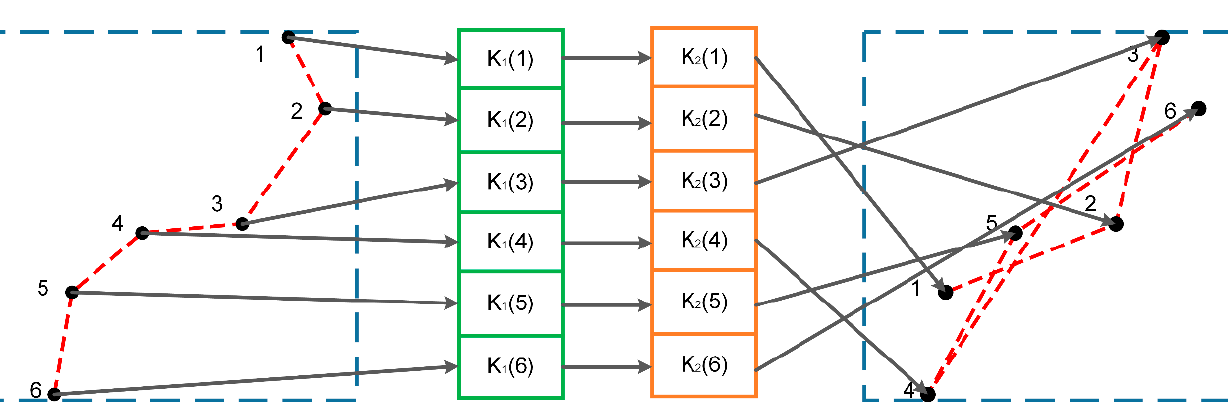
Figure 3. Double random position permutation.